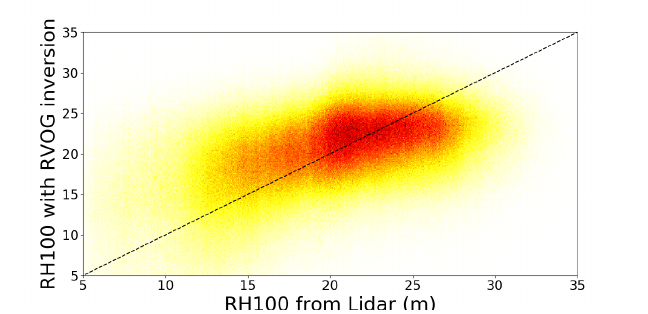
Figure 19. Density plot of LIDAR RH100 VS RH100 estimated by a RVoG based inversion method.